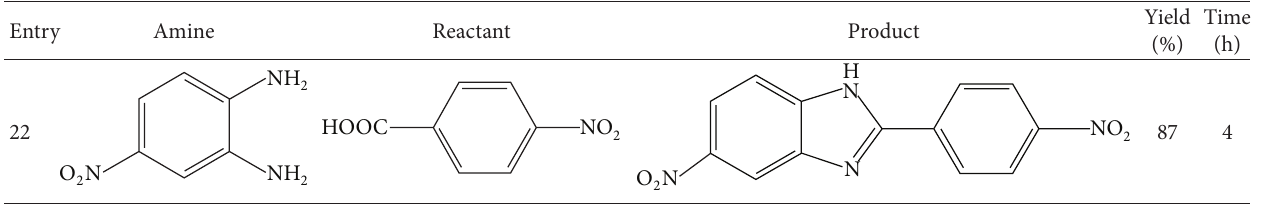
Table 3: Catalyst reusability study for the reaction of benzaldehyde with o -phenylenediamine a .